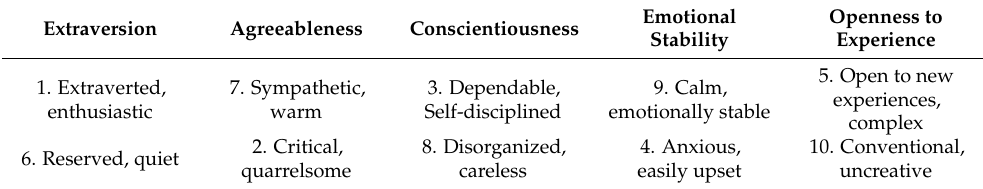
Table 2. Ten-item personality